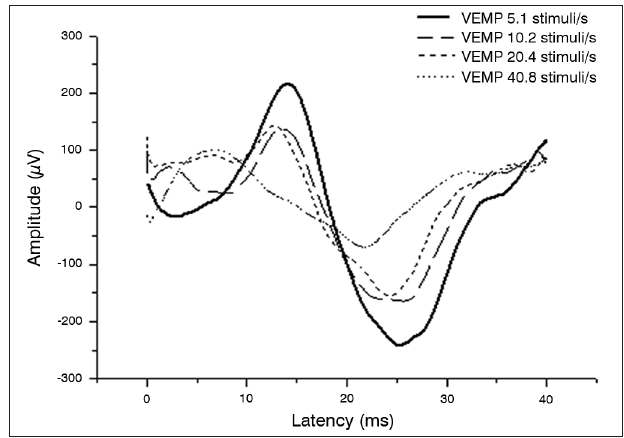
Graph 1. Comparison between amplitudes according to stimulation